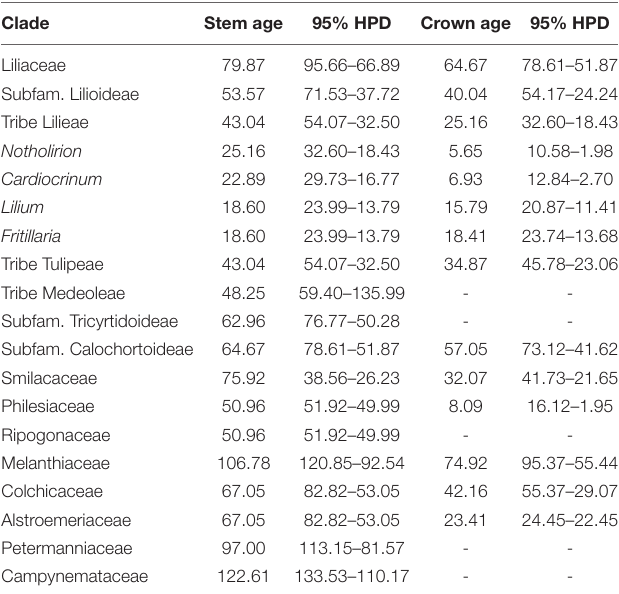
TABLE 1 | Inferred stem and crown ages (Ma) of Lilieae and other Liliales taxa, with upper and lower bounds of the 95% higher posterior density (HPD) for mean ages based on the analysis with 139 plastomes and six fossils calibration points (four based on fossils) (see Figure 2 ).